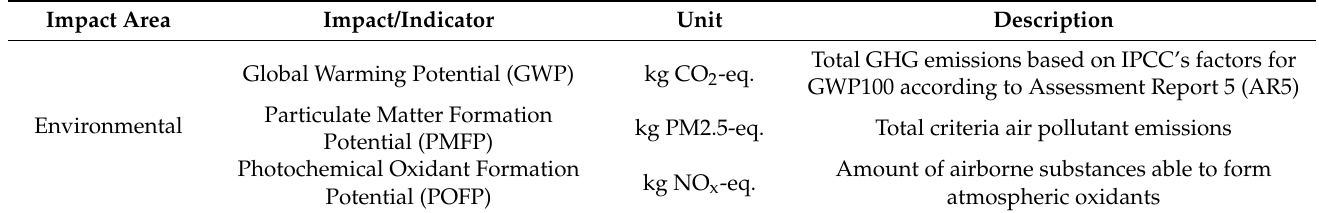
Table 1. Life cycle indicators of LNG LCA research.